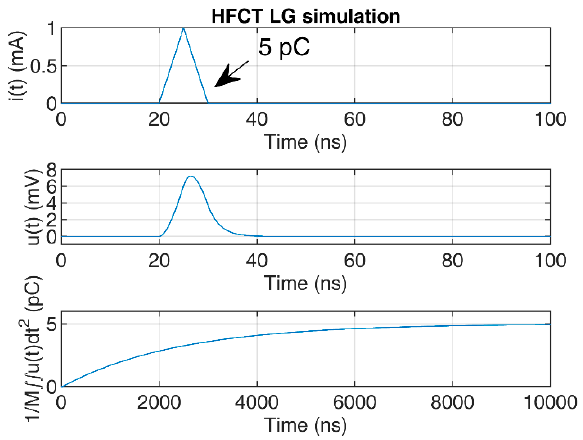
Figure 7. HFCT_LG sensor response and charge estimation of a 5 pC and 10 ns triangular current pulse.